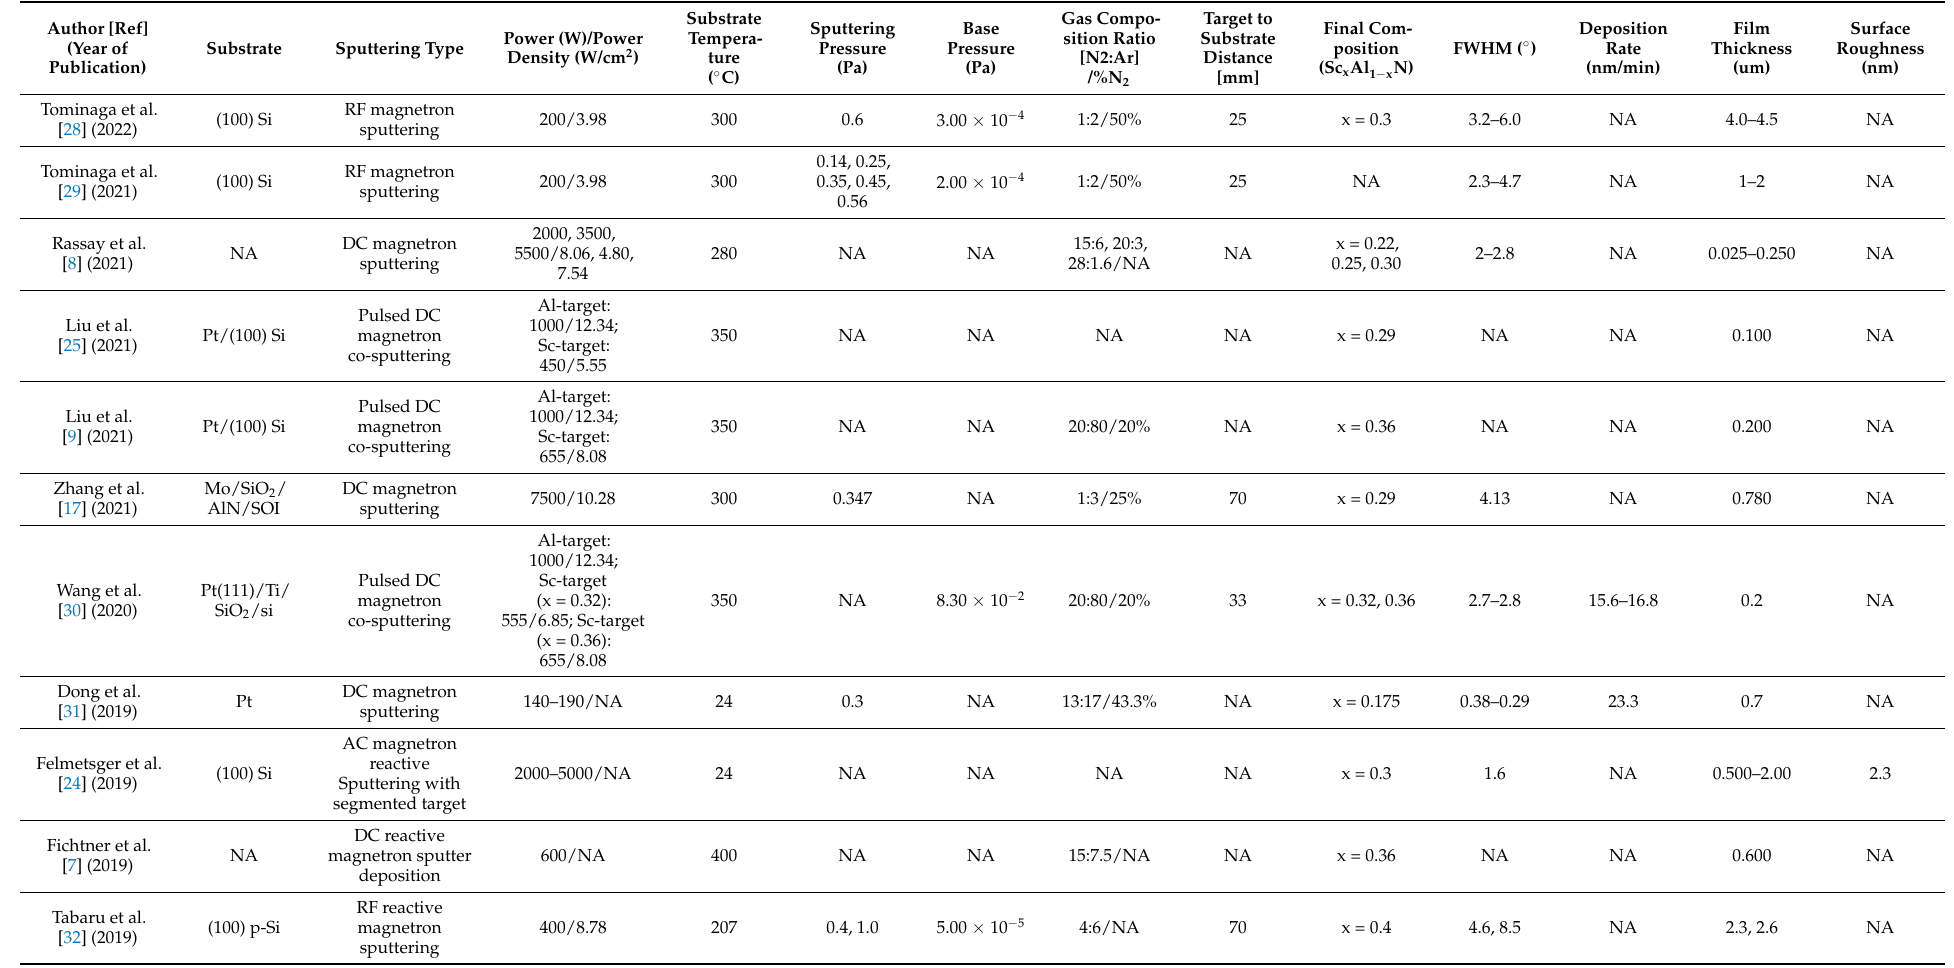
Table 2. Summary of sputtering deposited ScAlN growth